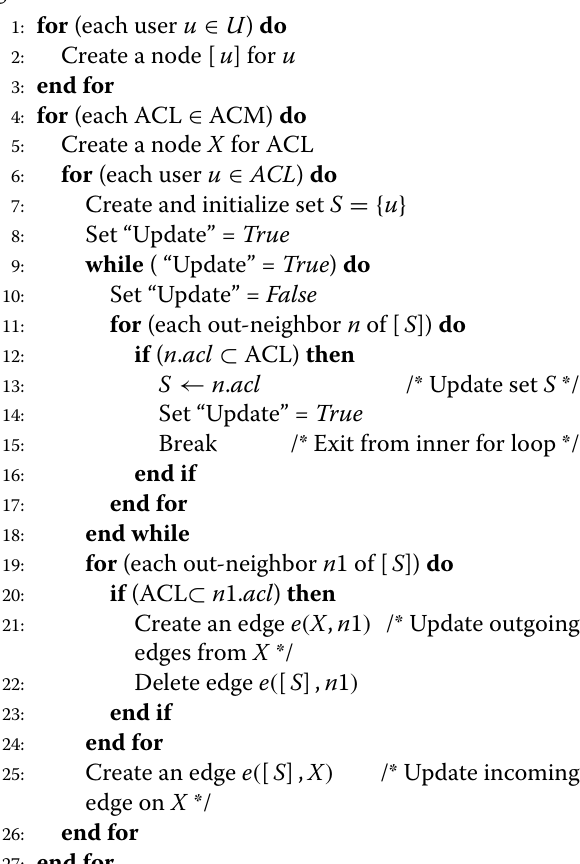
Table 3 Comparison of storage and key derivation cost Hierarchy →